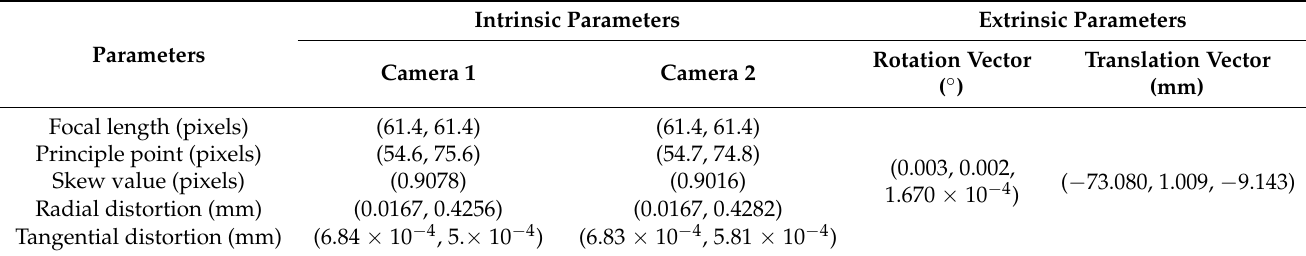
Table 3. Calibration results and estimation of intrinsic and extrinsic parameters of the stereo camera.